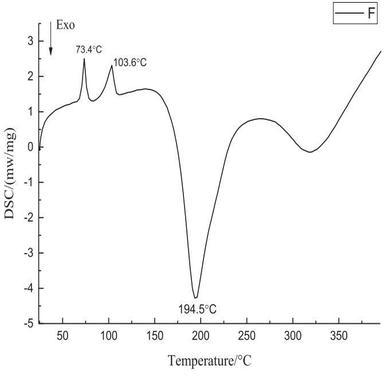
DSC curve for TNT-ATL.